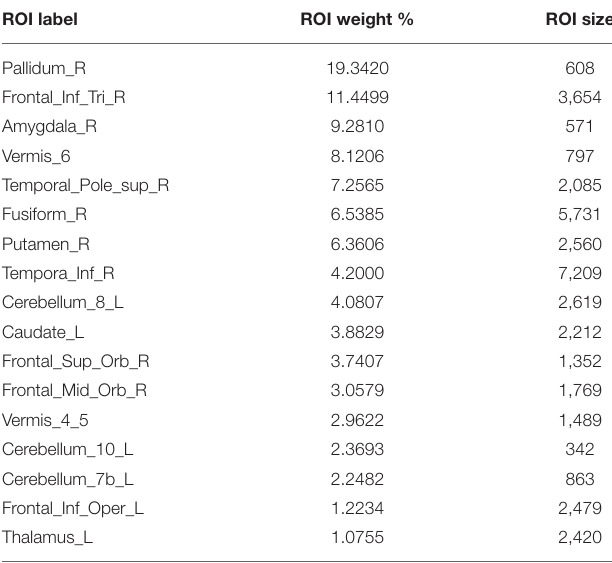
TABLE 3 | Main regions derived from the classification of BPD against BD. ROI